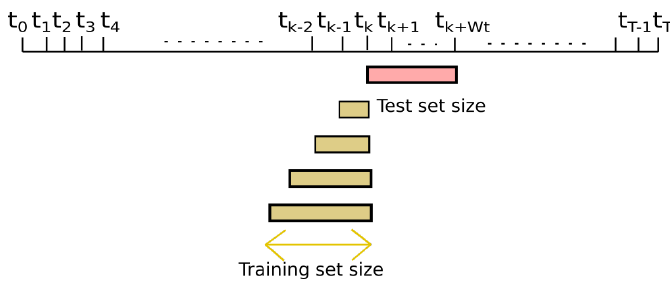
Figure 7. Case 2: Training set size increases in backward direction. Test set size